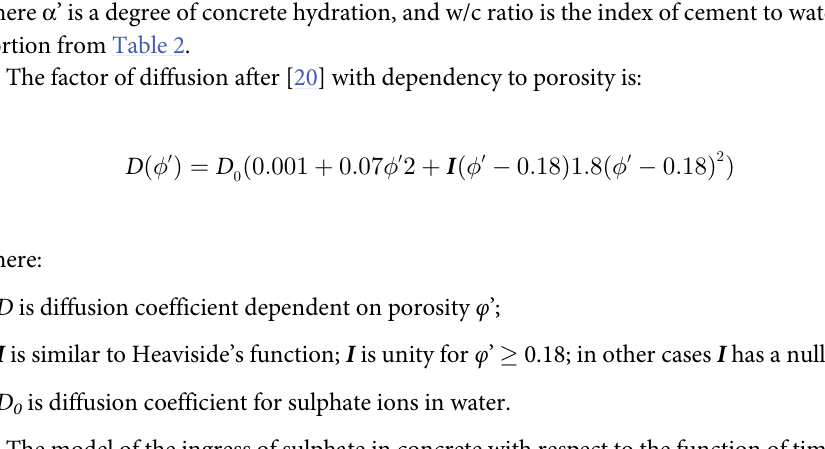
Fig 2. Transport ways for sulphate ions inside concrete trench (CMC) represents one dimensional regular grid in three percolations stages: a) concentration less than K , b) concentration more than K th